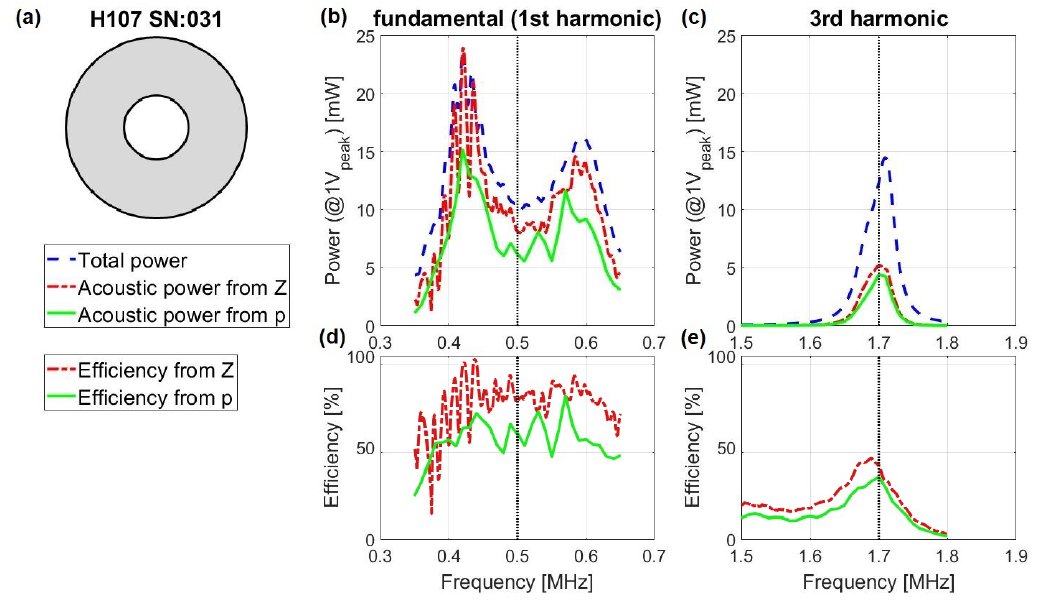
Figure 5. Comparison of electrically estimated (from impedance “Z” measurements) and acoustically measured (estimated from acoustic pressure “p” field measurements) power outputs (1 V peak drive voltage) of the H-107 (SN: 031) transducer. ( a ): Transducer surface schematic with the cutout. ( b , c ): Total (electric and acoustic) power and estimated and measured acoustic power. ( d , e ): Estimated and measured efficiency. The dotted vertical lines indicate the centre frequency defined by the manufacturer at the fundamental and third harmonic resonances of the